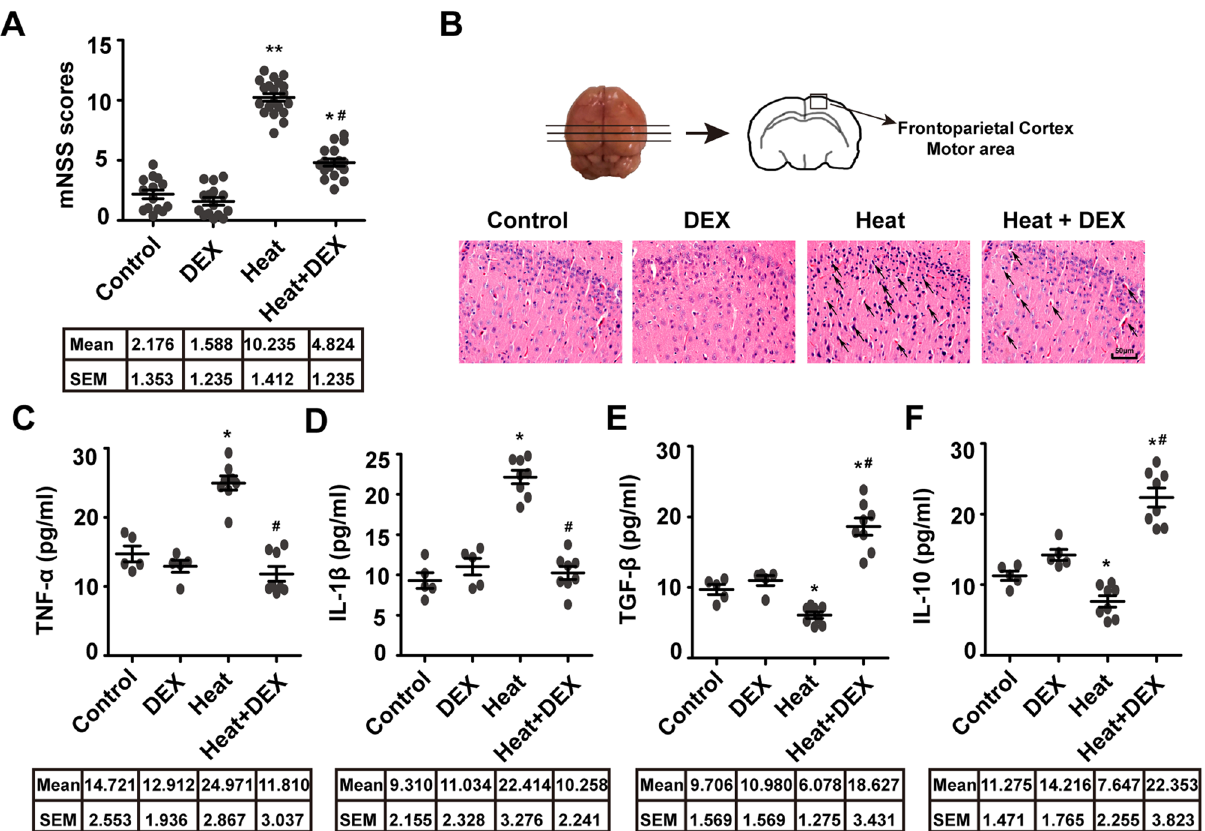
Figure 1. DEX reduces the nerve damage and neuroinflammation caused by heatstroke. ICR mice were exposed to an ambient temperature of 41 ± 0.5 °C until Tc > 42.7 °C (heatstroke onset), and then injected intraperitoneally with 25 µg/kg DEX (Heat + DEX group) or 0.9% saline (Heat group), followed by a 12-h recovery at an ambient temperature of 23 ± 1 °C. ( A ) The neurological function of mice was evaluated by the modified neurological severity score (mNSS). ( B ) Representative pathological pictures of brain sections stained with haematoxylin–eosin (HE) at a magnification of X-200. ( C – F ) Cytokine expression levels in the cerebral cortex were assessed by ELISA. The data are shown as the mean ± SEM of three independent experiments. Statistical analysis: two-way ANOVA. * p < 0.05, ** p < 0.001 vs. Control. # p < 0.05 vs.